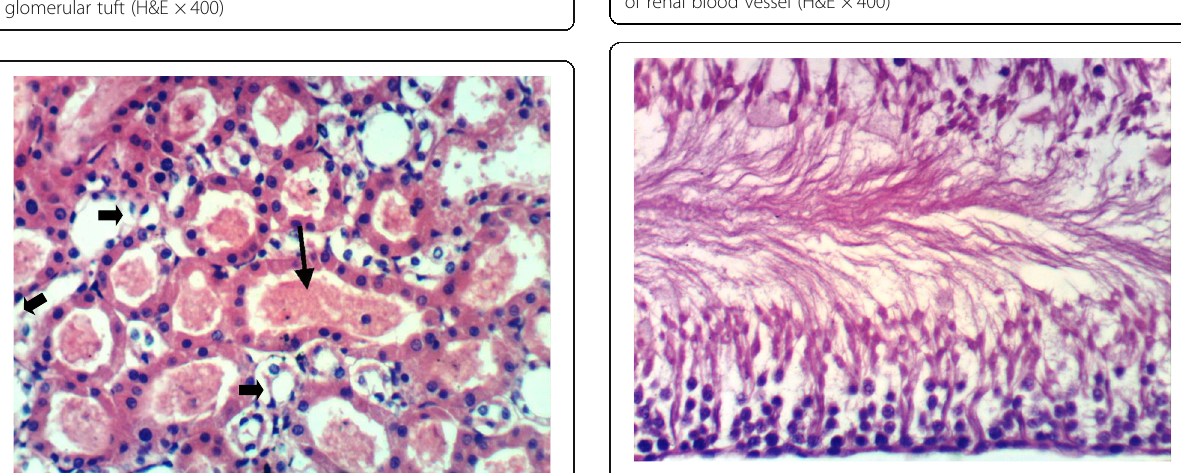
Fig. 13 Photomicrograph of rat ’ s testis fed the balanced diet supplemented with taurine and vaniilin +oral pot.bromateshowing nearly normal histological structure with complete spermatogenesis (H&E ×400)